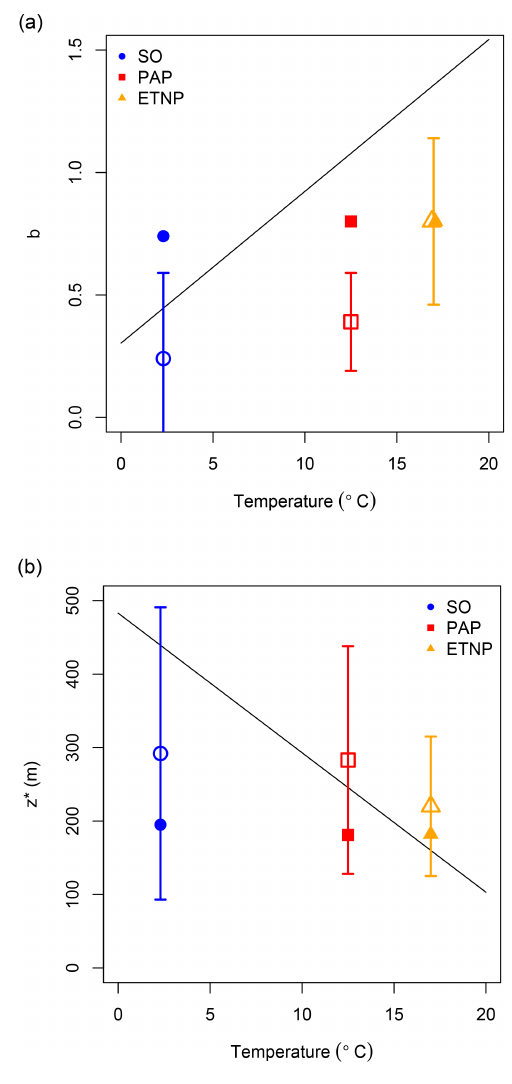
Figure 4. Total sinking POC attenuation coefficients (a) b and (b) z ∗ with temperature. Blue circles are Southern Ocean, red squares PAP, and orange triangles equatorial Pacific. Filled points show model output and open points are observations. Solid line is Marsay et al. (2015) regression. Error bars are standard error of the mean and only plotted on the observations as the error is too small in the model. See Table S2 for attenuation coefficients of fast and slow sinking